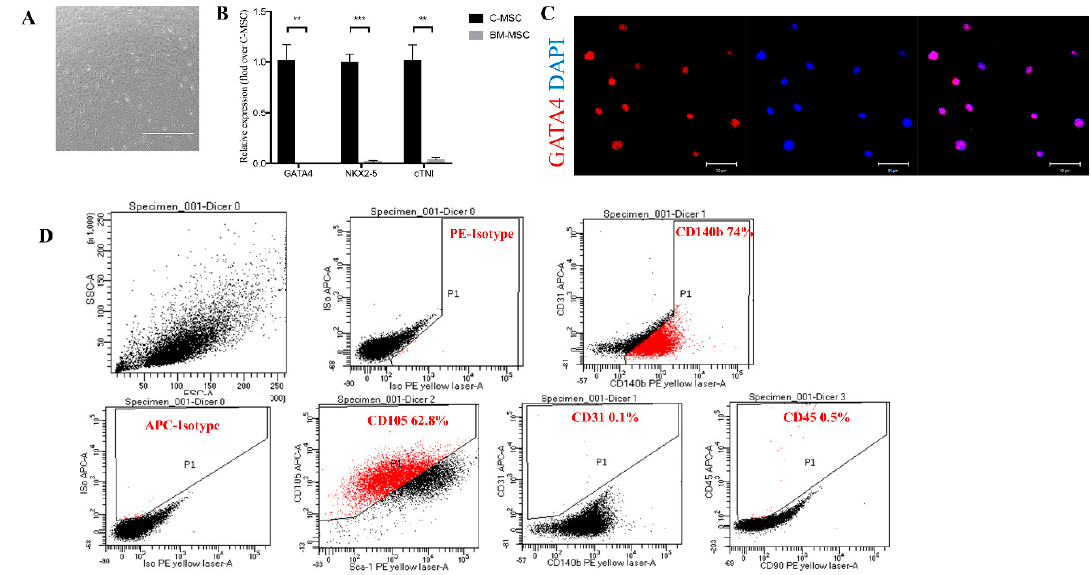
Figure 1. Characterization of cardiac mesenchymal stem cells (C-MSC). ( A ) Cultured C-MSC, scale